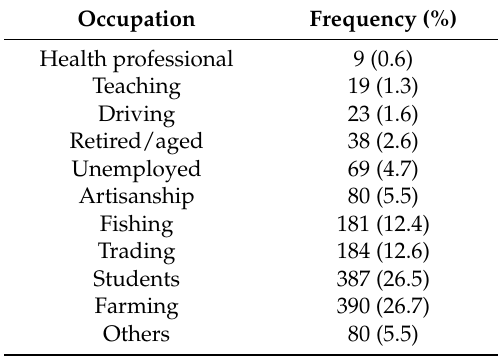
Table 1. Occupational distribution of study